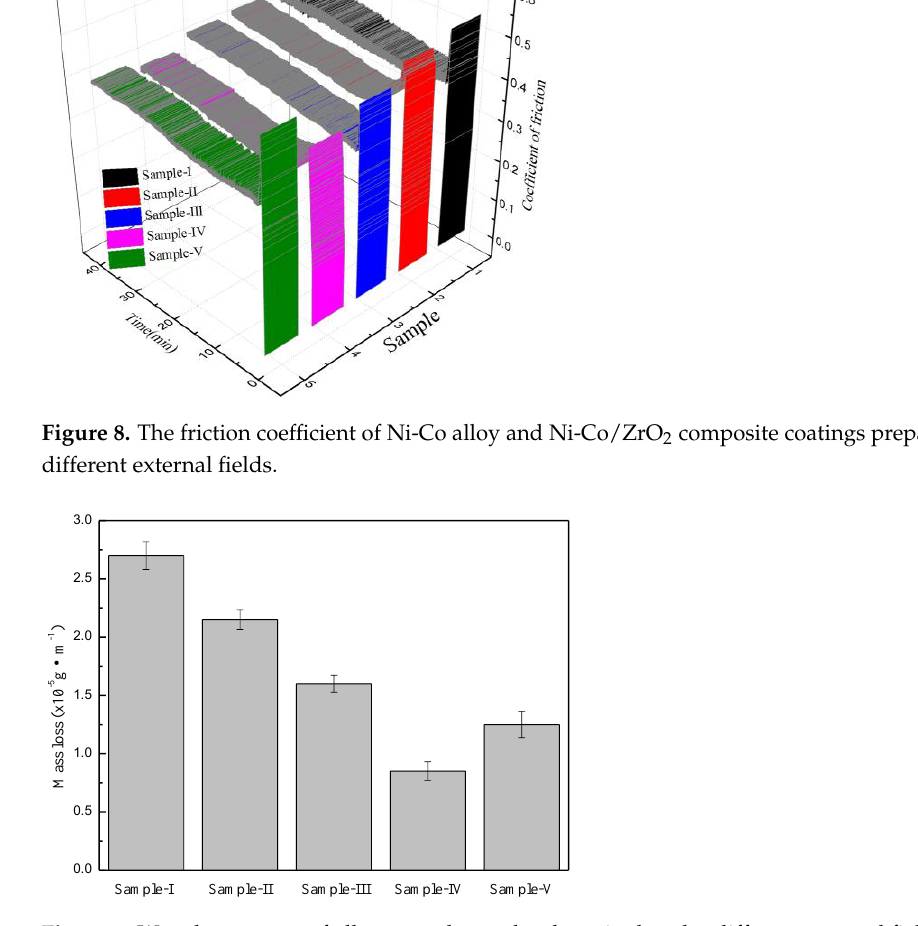
Figure 9. Wear loss curves of alloy coated samples deposited under different external fields.